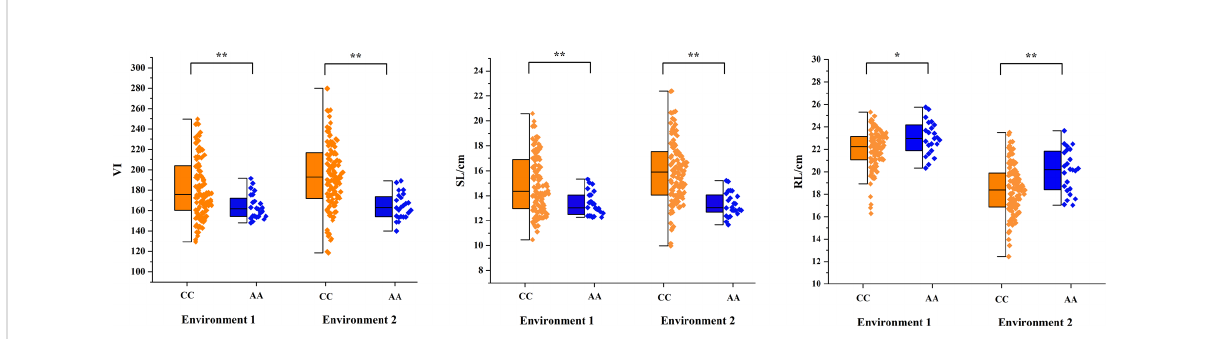
FIGURE 6 Allelic effects identi fi ed by the KASP marker in the natural population. Blue indicates the A allele of Zhongmai 895, and orange indicates the C allele of Yangmai 16. * and **, signi fi cant at P< 0.05 and P< 0.01,